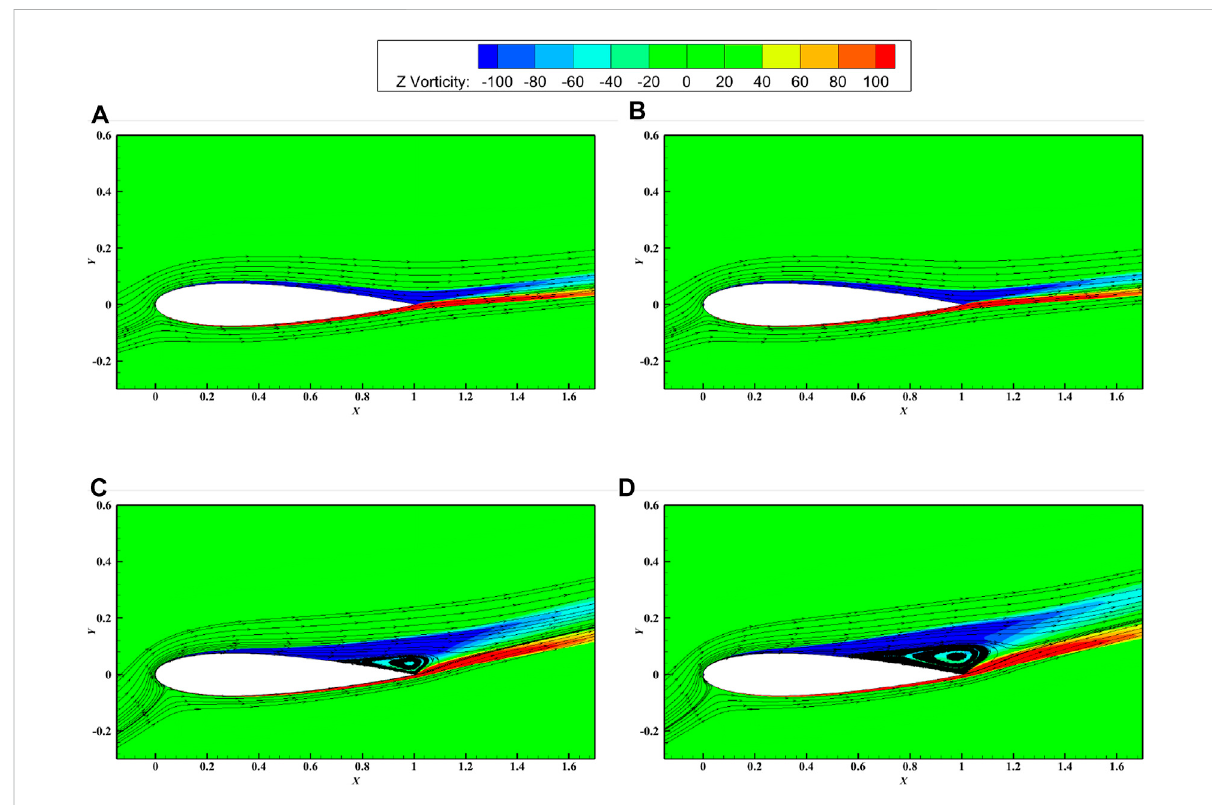
FIGURE 10 Schematic diagram of the surface streamline and vorticity of the NACA0015 original and semi-circular leading edge erosion airfoil ( h 1 = 0.5% c ). ( (A) : Original airfoil ( i = 8 ° ); (B) : Semi-circular erosion airfoil ( i = 8 ° ); (C) : Original airfoil ( i = 16 ° ); (D) : Semicircular erosion airfoil ( i = 16 ° ).